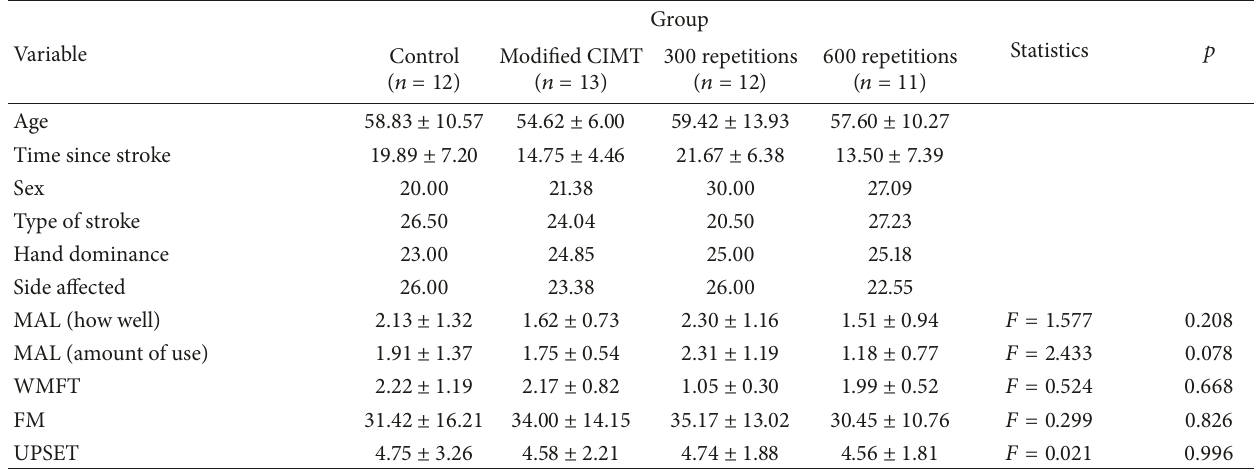
Table 1: Baseline characteristics of the study